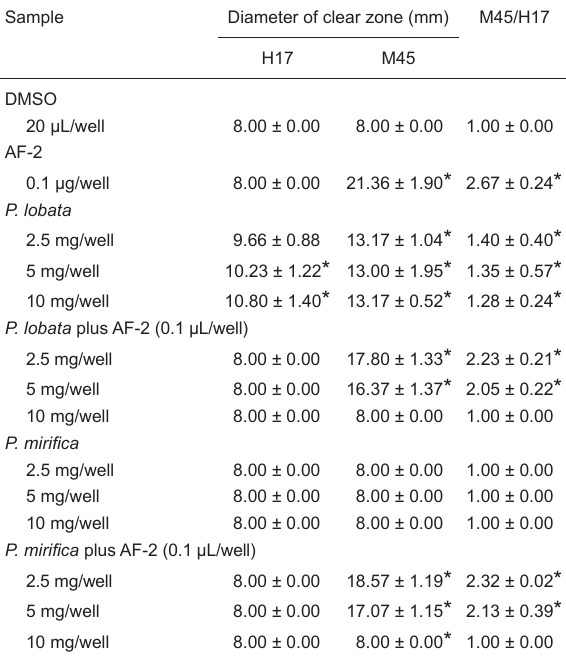
Table 3. Mutagenic and antimutagenic activity assay of Pueraria lobata and P. mirifica extracts based on non-metabolic activation in a rec assay using Bacillus subtilis var. H17 ( rec + ) and M45 ( rec - ) as reporter